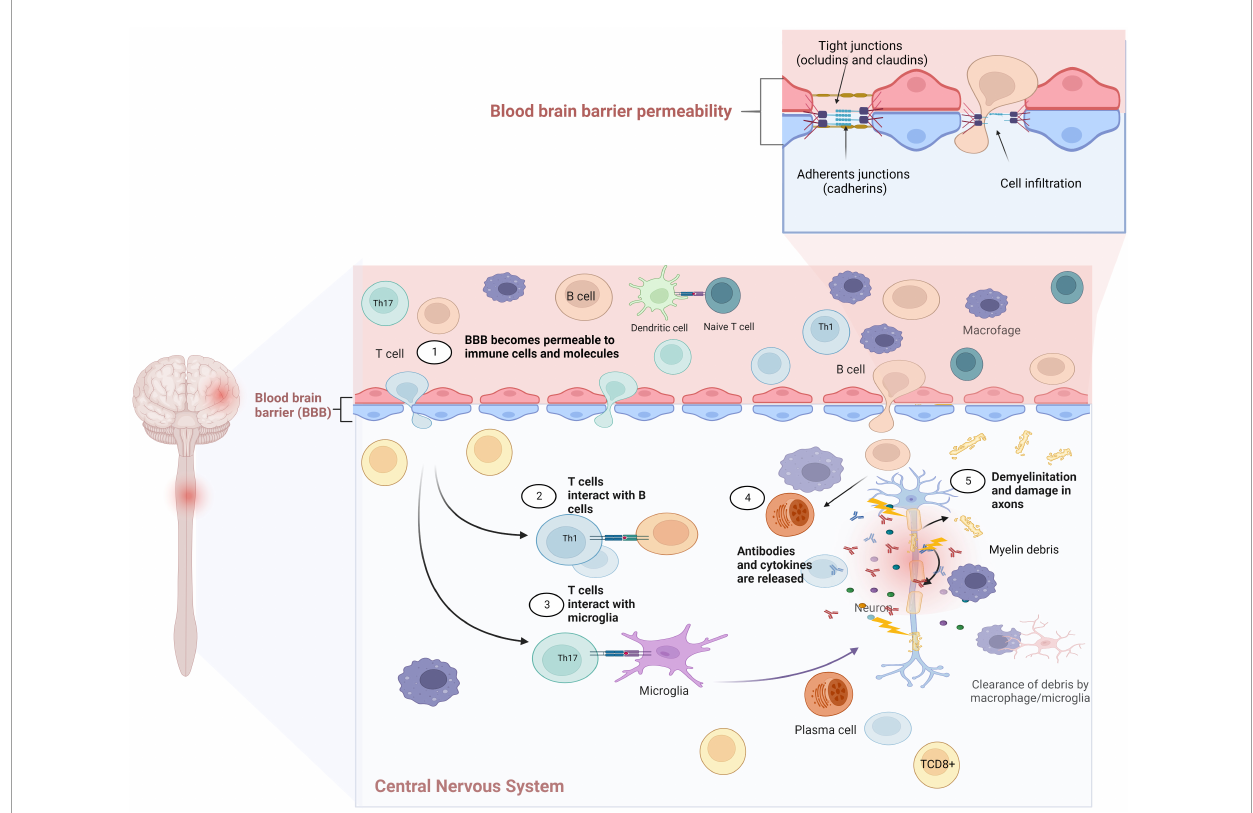
FIGURE1 Dendritic cells can activate autoreactive T cells and promote clonal expansion in the lymph nodes. T cells differentiate to Th1 and Th17, which releases proinflammatory cytokines (IFN- γ , IL-17). These cells invade the central nervous system (CNS) and are reactivated, inducing a positive loop that continues to promote the autoactivation of autoantibodies and autoreactive T cells. The presence of these autoreactive Th1 and Th17 cells, cytotoxic T lymphocytes and B lymphocytes in the CNS, with astrocytes and activated microglia will lead to increased production of inflammatory cytokines, nitric oxide (NO), glutamate-mediated excitotoxicity, autoantibody production, and cytotoxicity, leading to damage and destruction of the myelin sheaths and axons. Created with